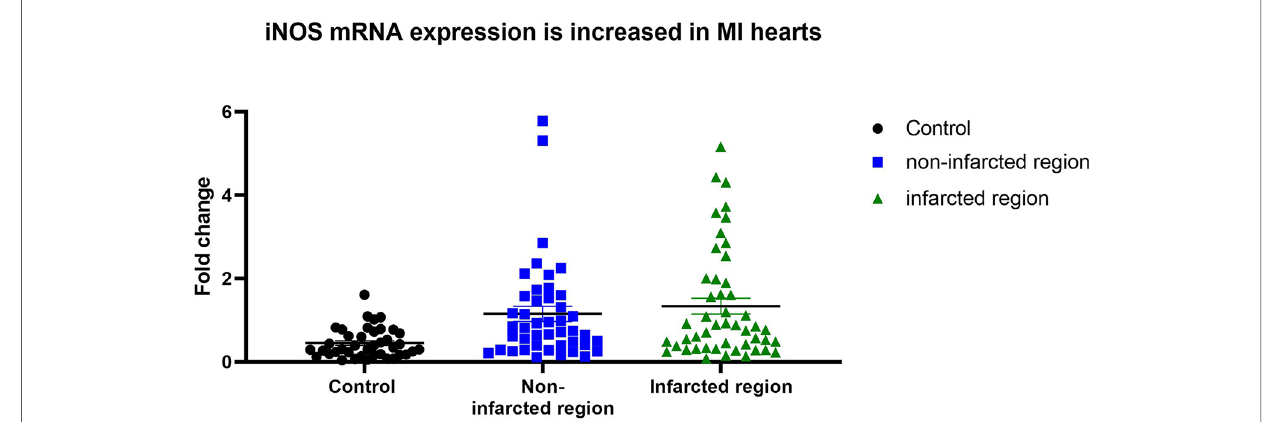
FIGURE 1 iNOS expression in controls, non-infarcted and infarcted regions. iNOS mRNA expression level in control hearts ( n =10), in non-infarcted ( n =23) and in infarcted ( n =25) regions of MI hearts were determined by qPCR. Individual values were plotted and show signi fi cant upregulation of iNOS expression in infarcted regions in comparison to controls Linear mixed effects model was applied and signi fi cance was adjusted after normality by using Tukey ’ s multiple comparisons test.